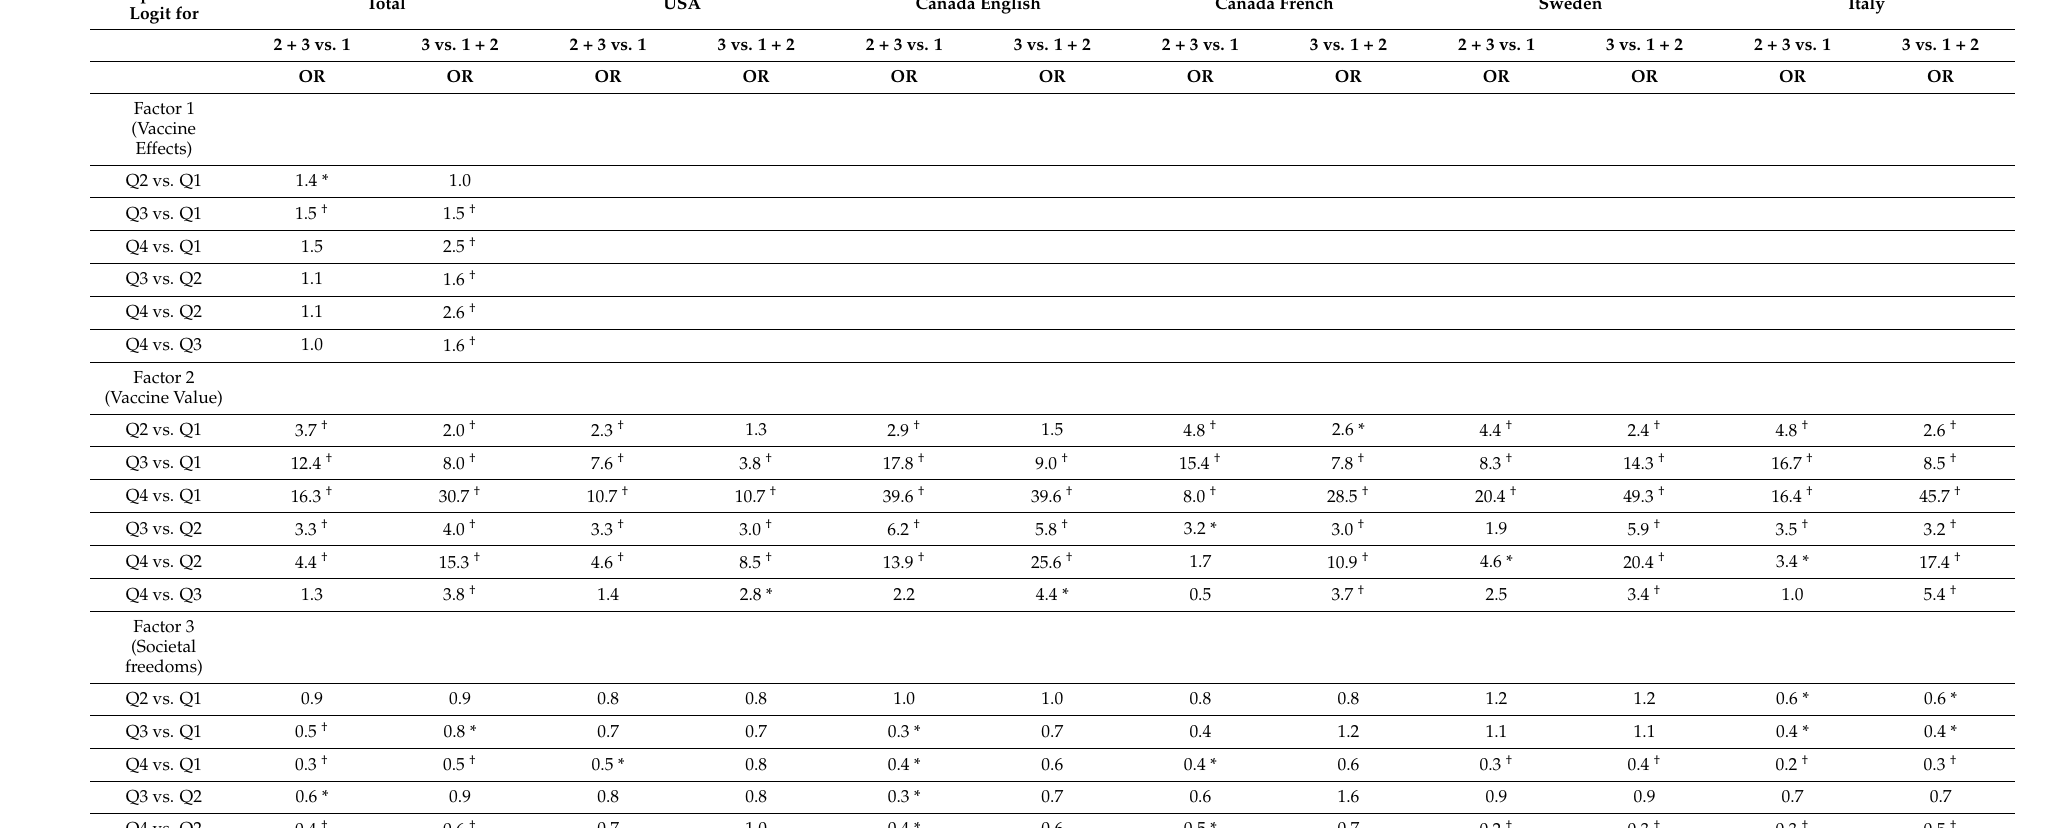
Table A3. Model-based estimated odds ratio for likelihood to vaccinate, for contrasts between quartile of factor scores. Population Logit for